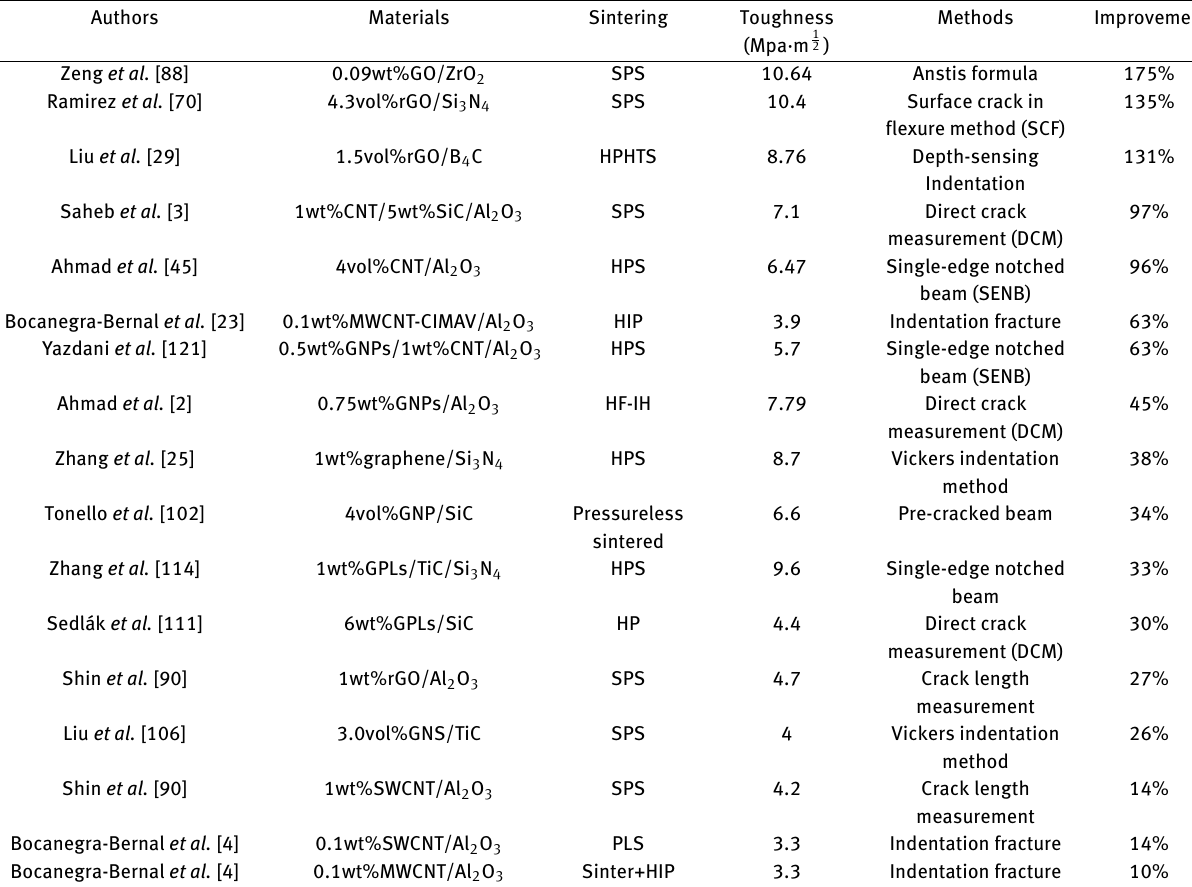
Table 1: The common methods of toughness measurement